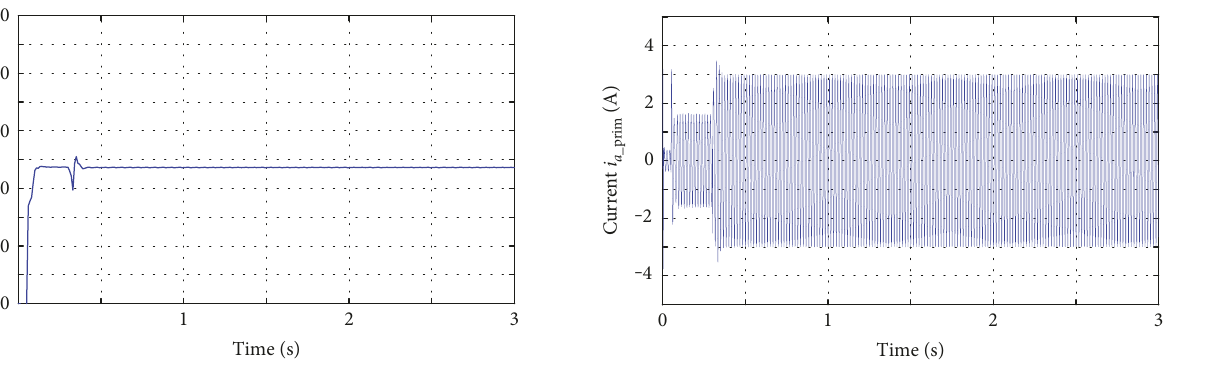
Figure 16: Active power injected into the grid at a 30% decrease of grid voltage.